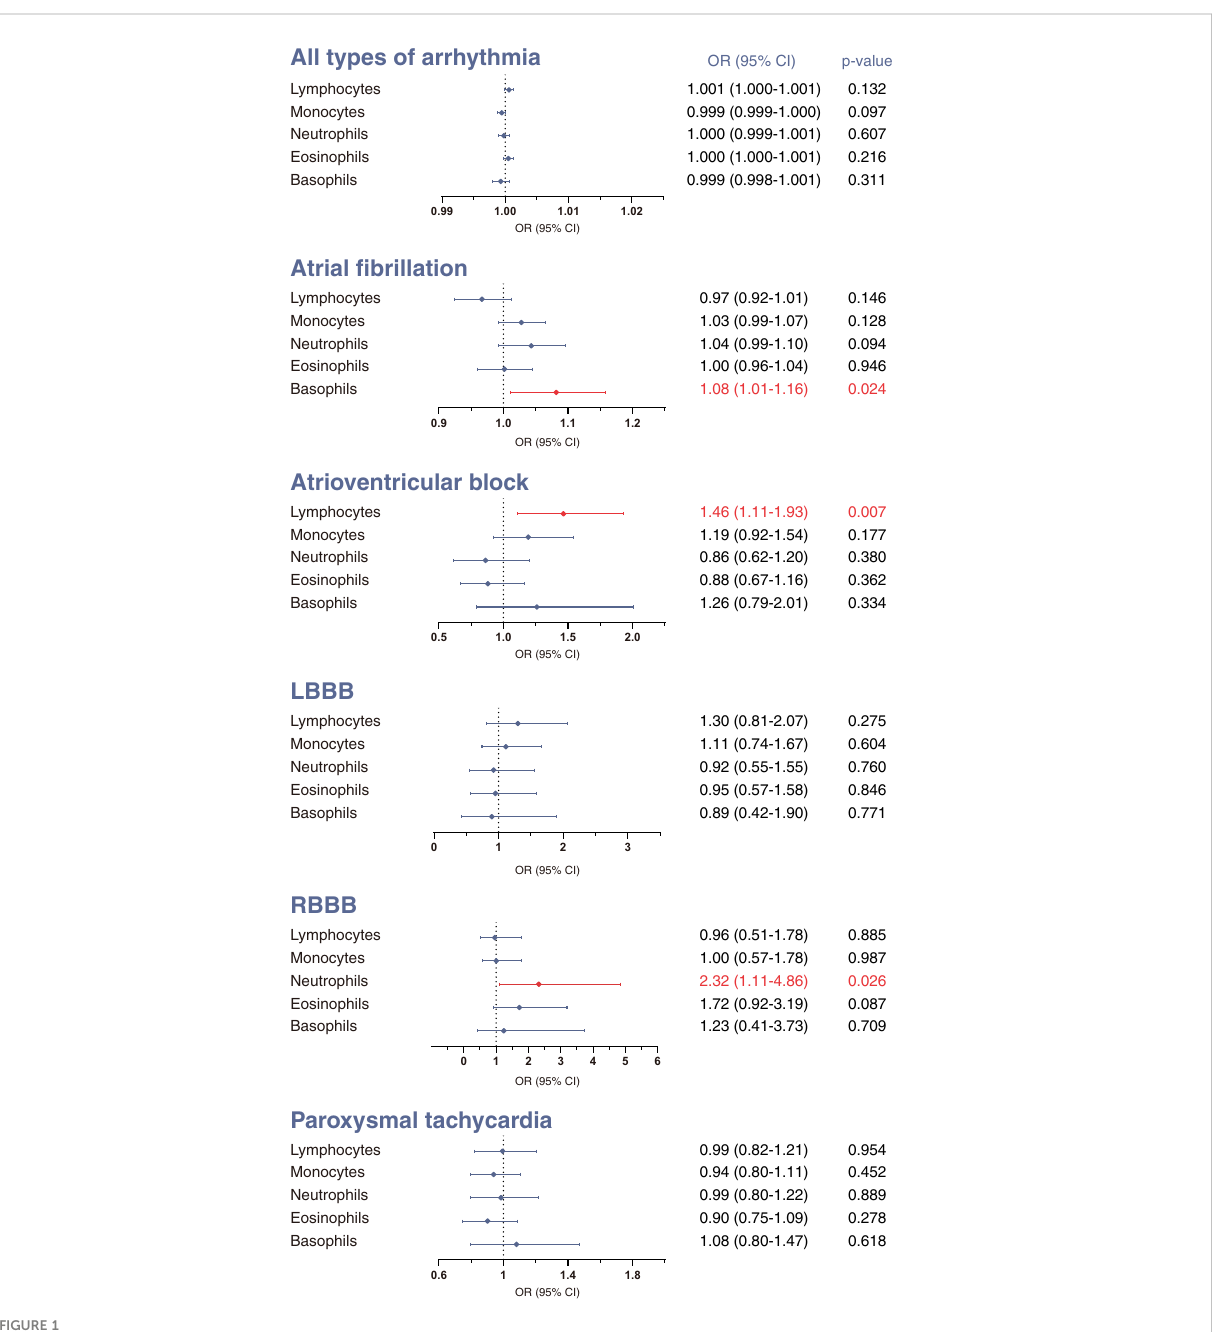
the conventional IVW approach, but robust to different forms of biases (see Methods). Therefore we conducted MR-Egger, MR- PRESSO, weighted median, Steiger fi ltering and multivariable MR analyses on the following three combinations of exposure and outcome: (1) lymphocyte count and atrioventricular block, (2) neutrophil count and RBBB, and (3) basophil count and atrial fi brillation.